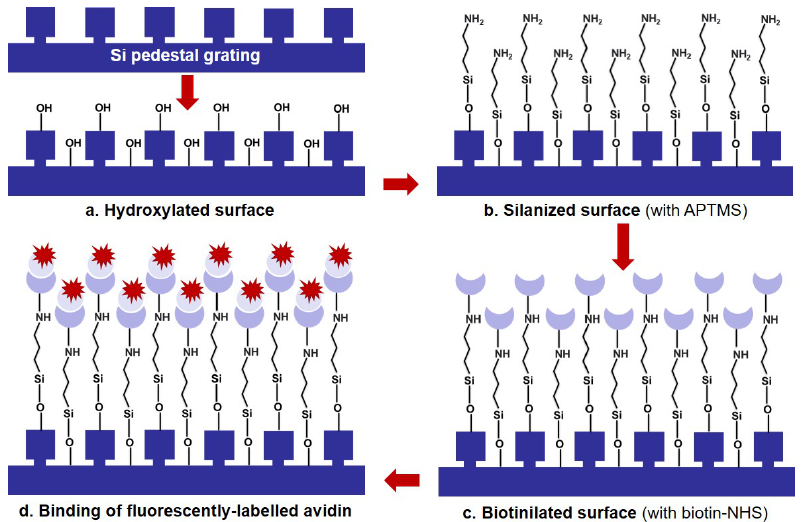
Figure 3. Functionalization protocol for the optical biosensor. ( a ) The Si pedestal grating is hy- droxylated by piranha treatment, ( b ) Silanization of the surface results in an APTMS monolayer, ( c ) The surface is biotinilated using a biotin-NHS compound that covalently bonds to the amino groups of APTMS, ( d ) The fluorescently-labelled avidin is recognized by the biotin and thus bound to the surface.